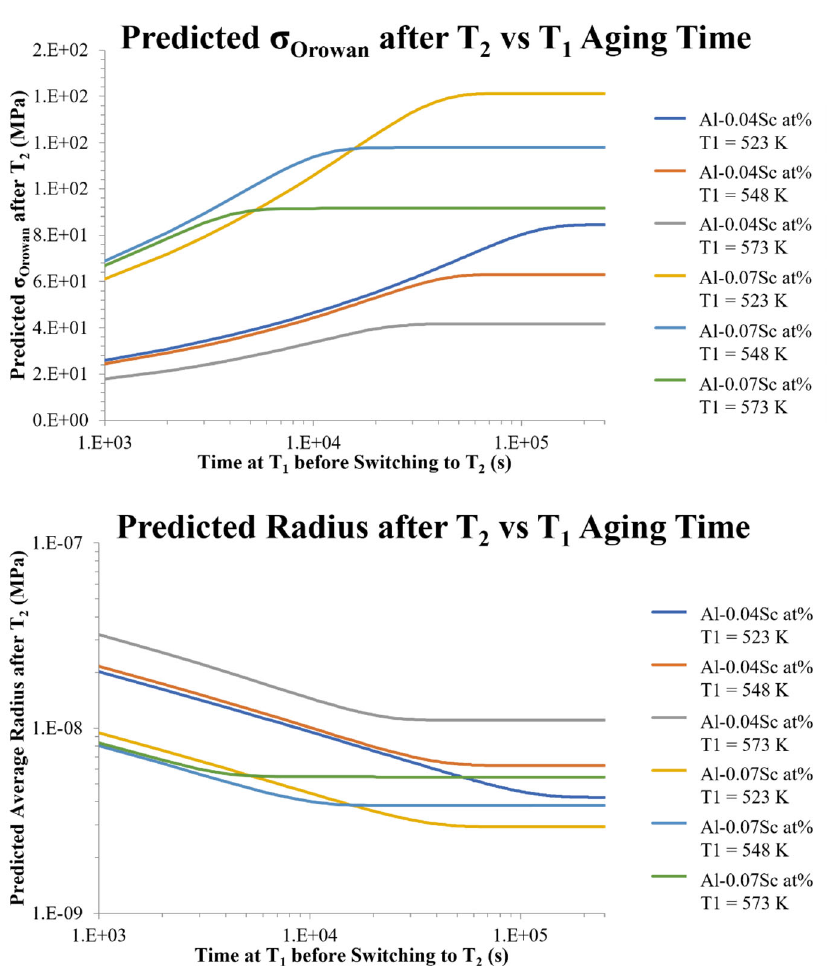
Figure 9. Graphs demonstrating how varying the time and temperature of the first heat treatment step (t 1 and T 1 , respectively) affect the predicted precipitate size and Orowan strengthening after heat treating at a second heat-treatment temperature (T 2 ) that is sufficiently high to completely deplete excess solute atoms in the matrix.